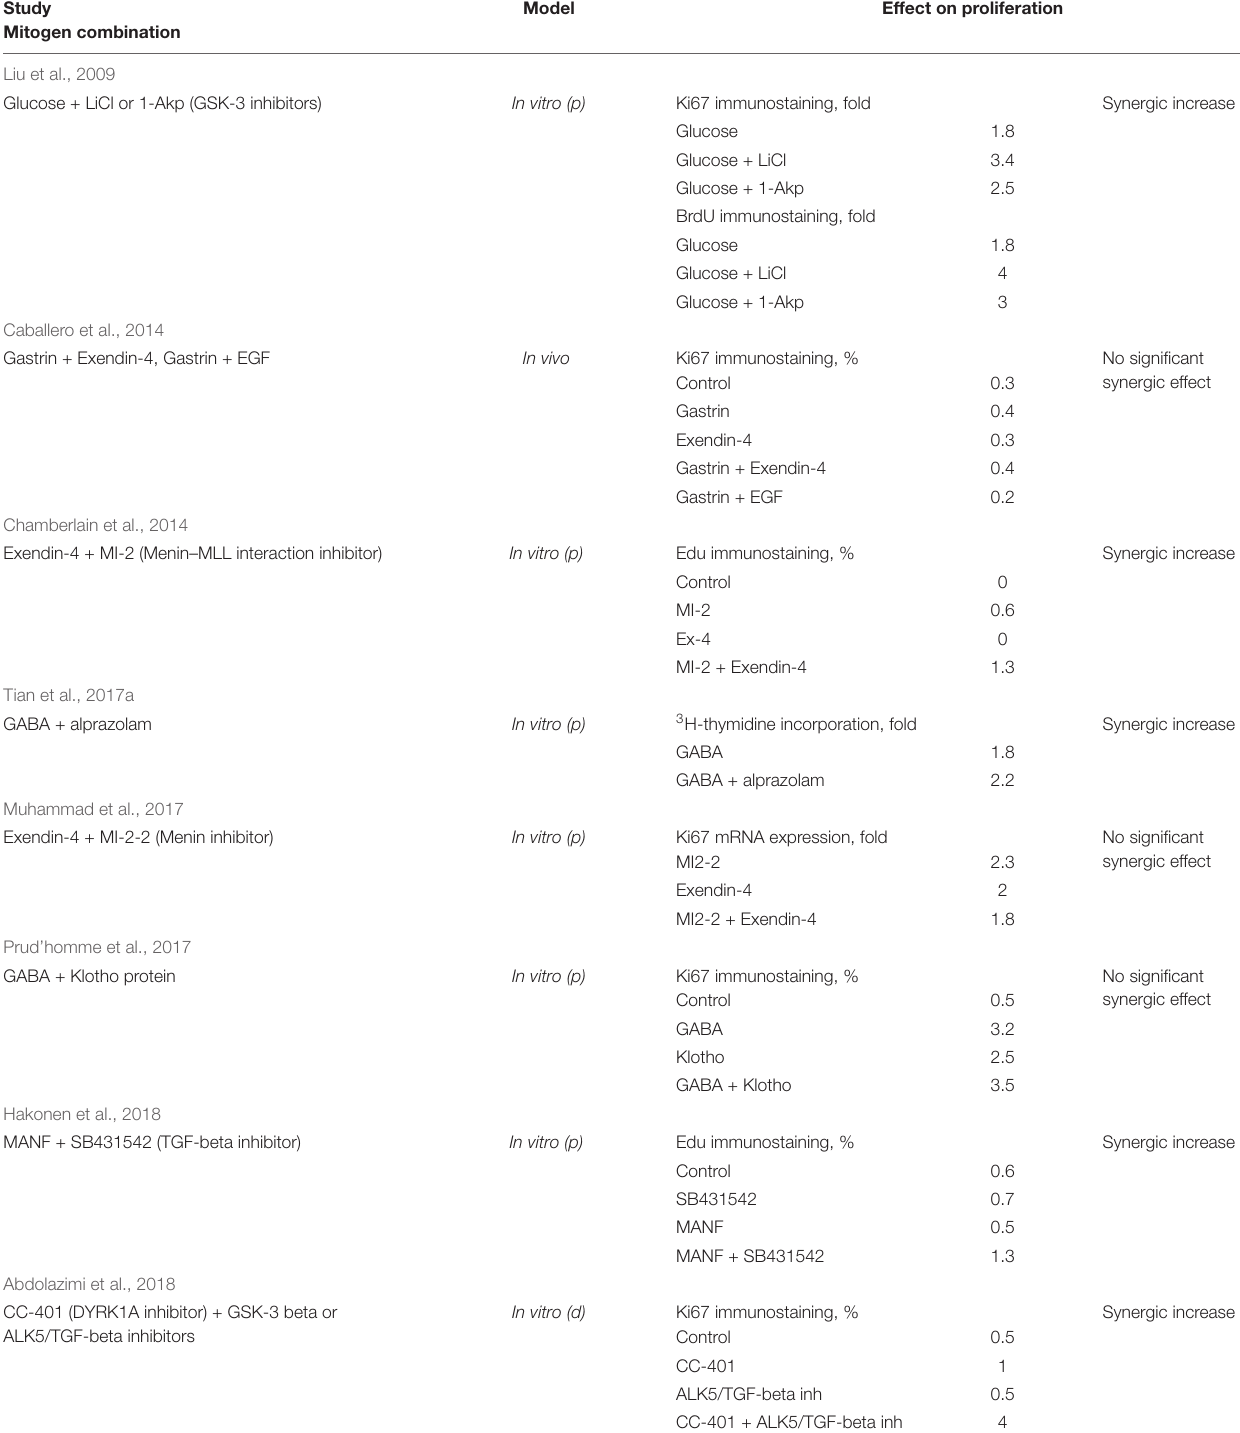
TABLE 2 | Studies on synergic action of compounds with human beta cell mitogenic